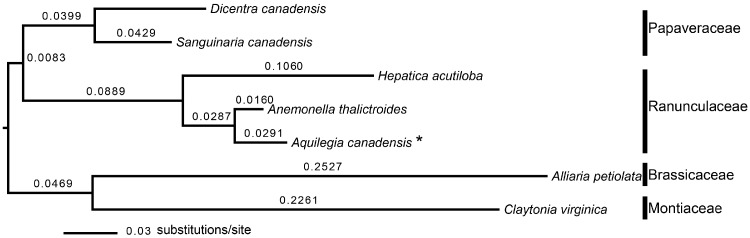
The molecular maximum likelihood phylogeny (phylogram), based on four DNA regions (rbcL, matK, trnL-trnF, ITS, [see Supporting Information—Table S1]), with branch lengths in substitutions/site above the branches. *Focal species A. canadensis was grown in the glasshouse-conditioned soils of six heterospecifics.